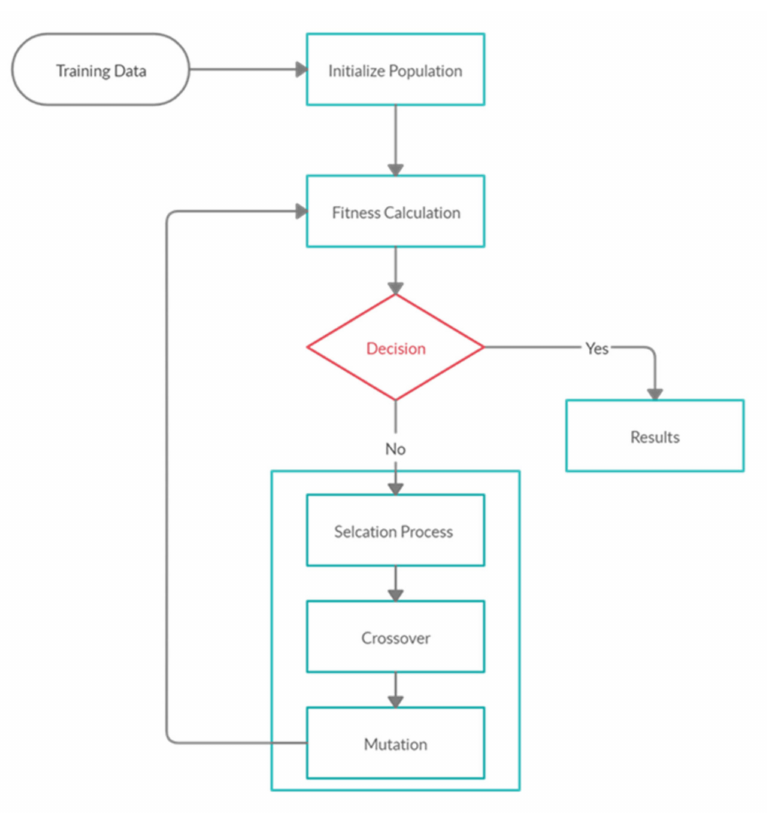
Figure 1. Block diagram of the proposed model based on genetic